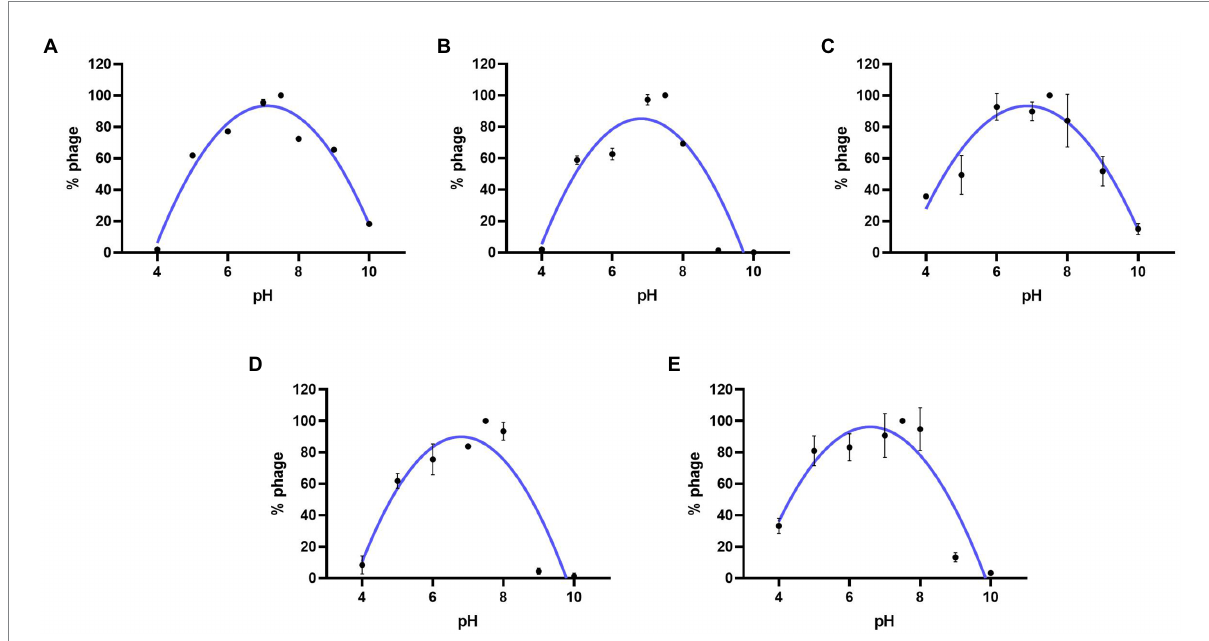
FIGURE 5 pH stability of phages JD-Fnp1 ~ JD-Fnp5. (A) JD-Fnp1; (B) JD-Fnp2; (C) JD-Fnp3; (D) JD-Fnp4; (E) JD-Fnp5. The x-axis represents the pH range; the y-axis shows the percentage of the active phage titers in different pH values to that in pH 7.5. All experiments were repeated in